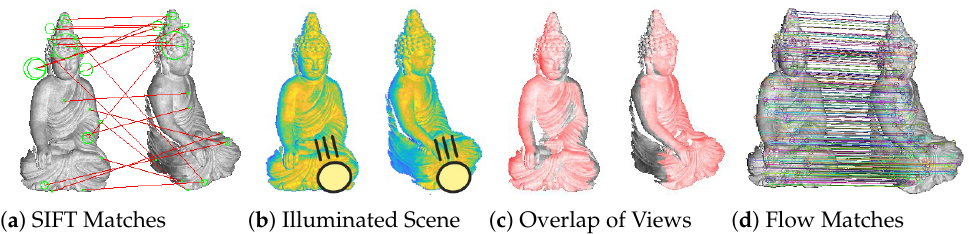
Figure 2. ( a , d ) show matches based on SIFT features and optical flow. ( b ) shows the scene, which has been illuminated by a strong spot light, in a different color space that is more visual to human perception. This more clearly visualizes the different shadings of the object, which is the reason for the failure of the common method based on SIFT features. ( c ) shows overlapping regions of subsequent scans. Even a rotation of approx. 45° yields a large overlap of more than